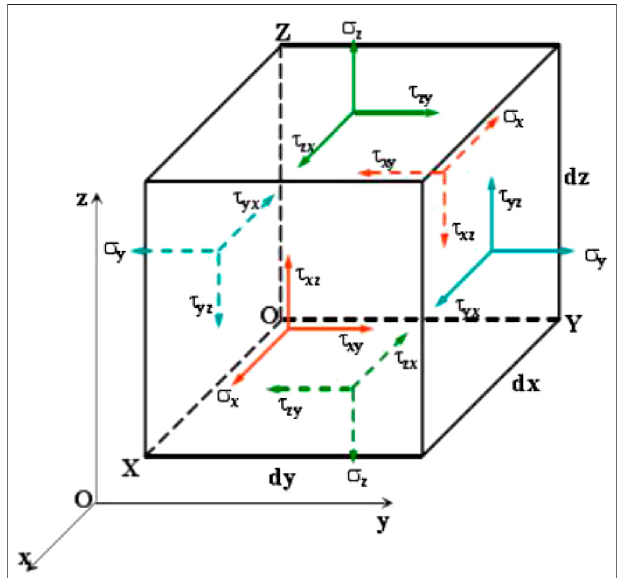
FIGURE 2 | Schematic diagram for stress state of the element in the